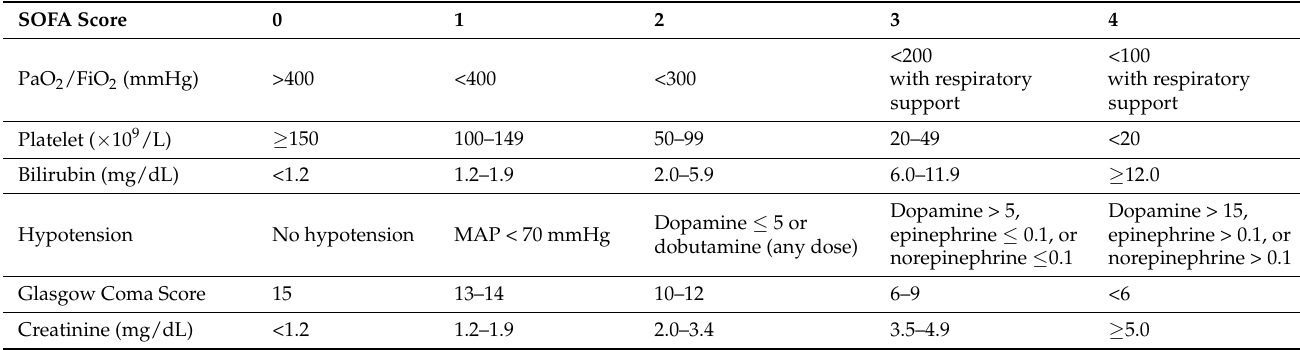
Table 2. Sequential Organ Failure Assessment (SOFA)